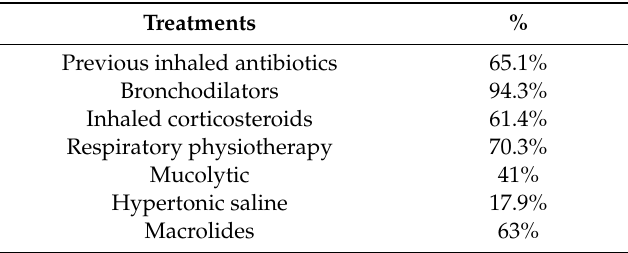
Table 2. Baseline and previous treatments of the patients.